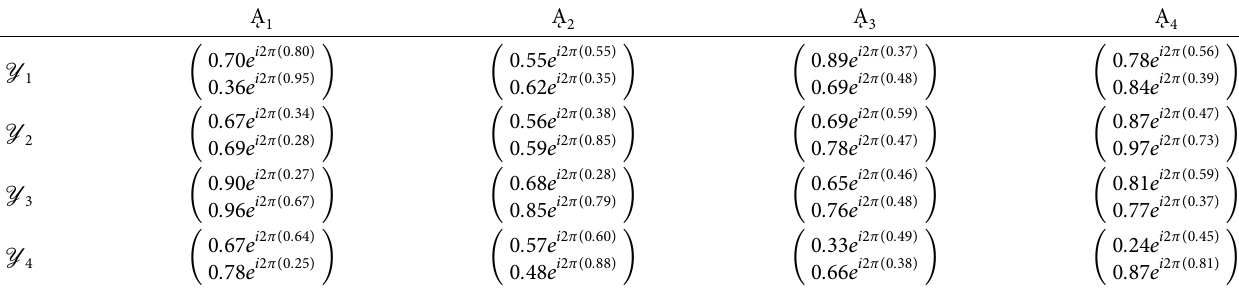
Table 10: DM matrix from Example 2.